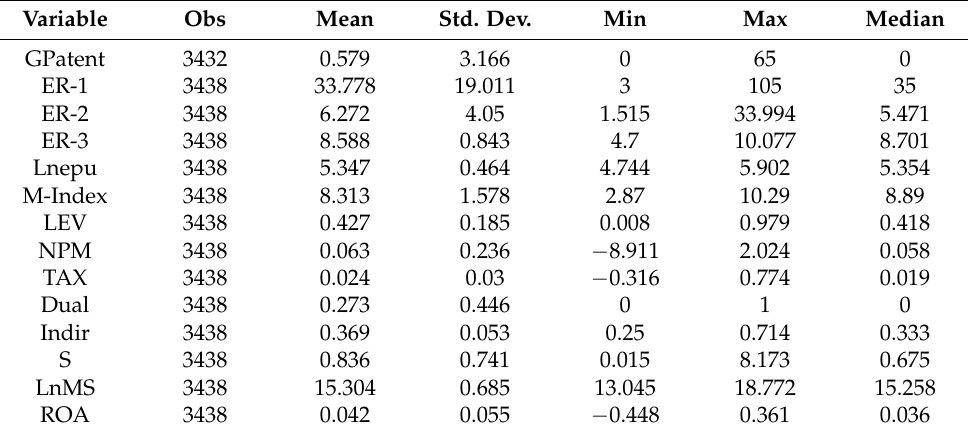
Table 2. Descriptive statistical